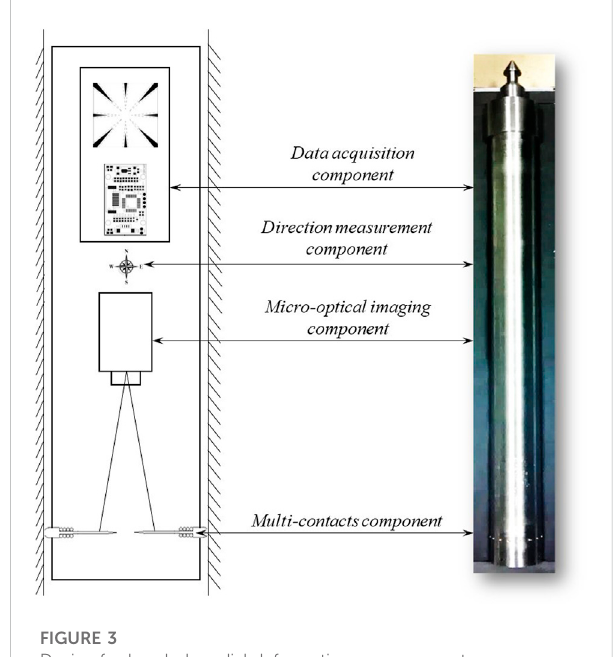
FIGURE 3 Device for borehole radial deformation